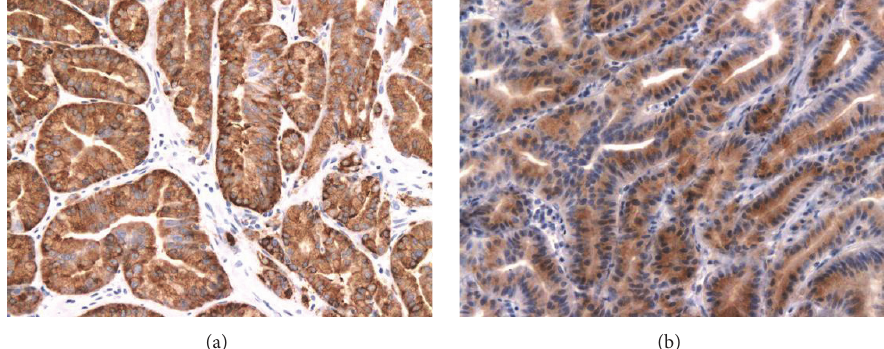
Figure 6: The neoplastic glands are diffusely reactive for MUC6 (a) (MUC6 immunostain × 200) and pepsinogen-I (b) (pepsinogen-I immunostain ×